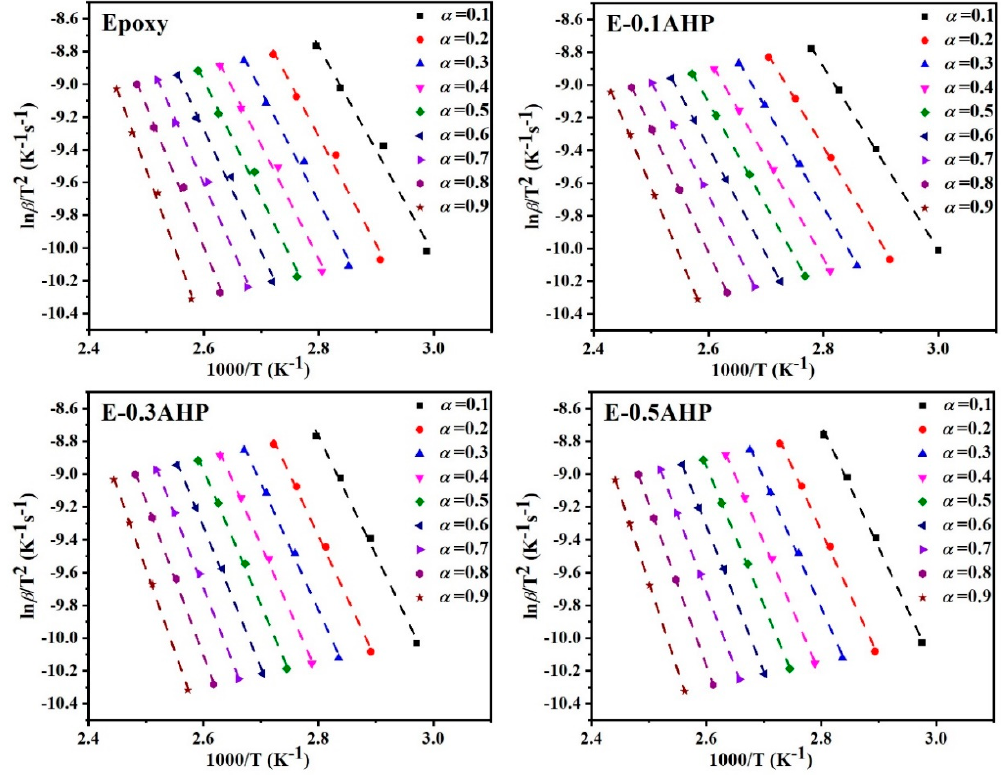
Figure A2. Plots of ln ( β / T 2 ) vs. 1 / T for prepared samples based on the Kissinger model.